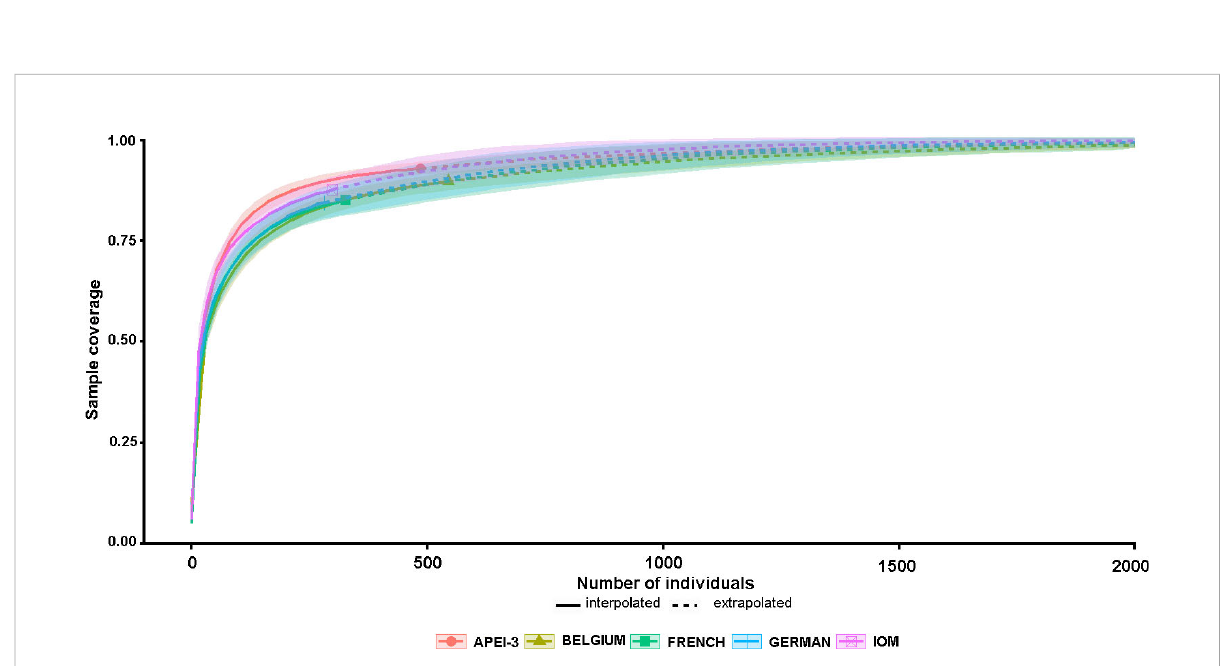
FIGURE 8 Sample completeness curves based on actual species richness, extrapolated to estimate how species richness would increase if entire foraminiferal assemblages were